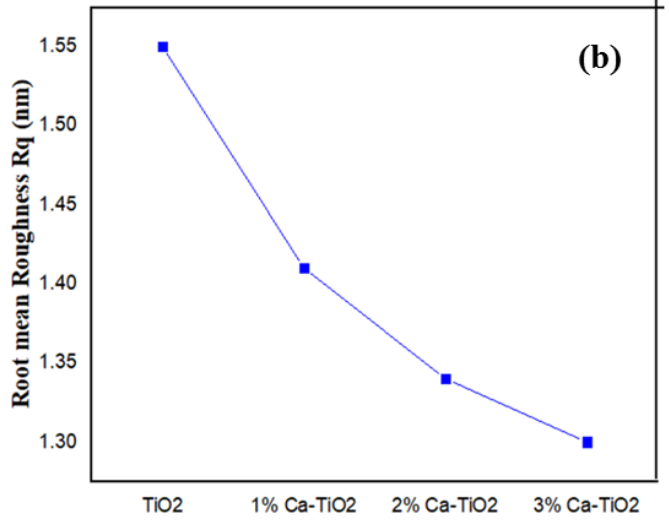
Figure 5. ( a ) Mean roughness (Ra) comparison of undoped TiO 2 , 1 wt%, 2 wt%, and 3 wt% Ca-TiO 2 and ( b ) root mean square roughness (Rq) comparison of undoped TiO 2 , 1 wt%, 2 wt%, and 3 wt% Ca-TiO 2 .